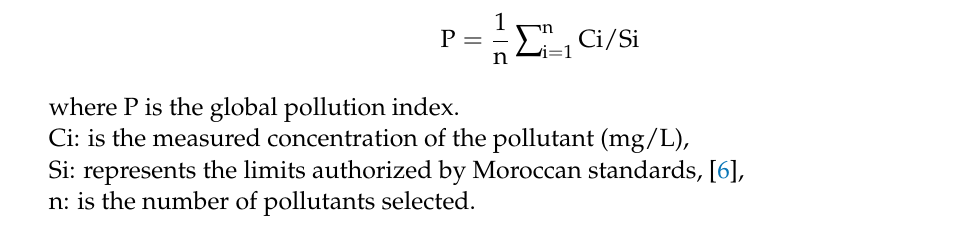
Table 2. Surface-water-quality classification standard